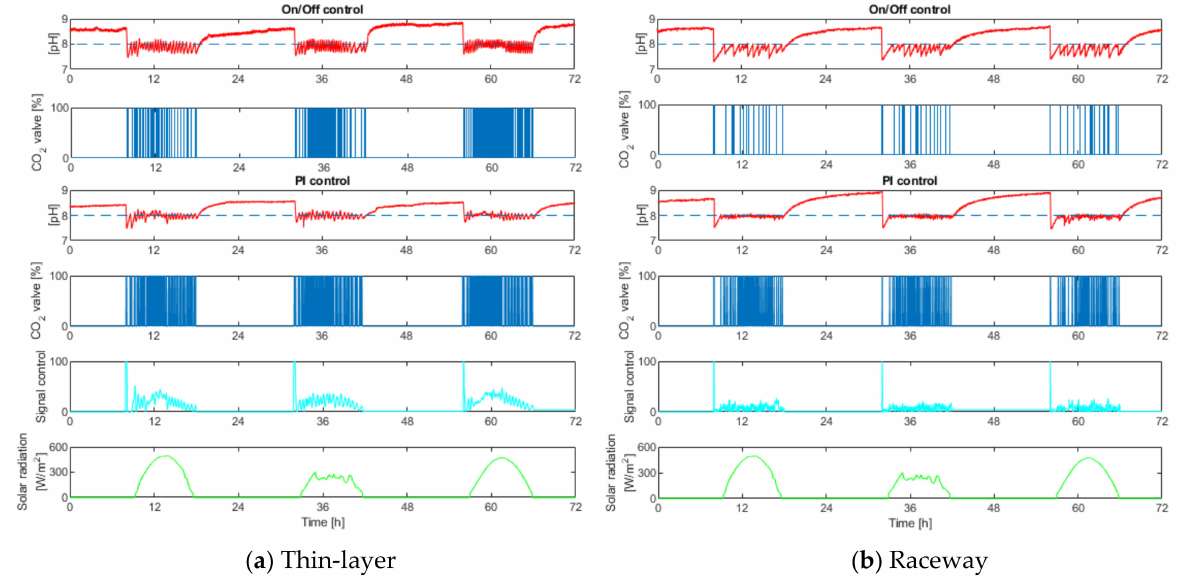
Figure 7. Results of the On/Off control and PI control architectures operated during the day, in thin-layer ( a ) and raceway ( b ) reactors. First graphs represent the evolution of the pH with On/Off controller (continuous red line), and the set-point established (dashed blue line). Seconds graphs represent the CO 2 valve state of On/Off control, Pulse Width Modulation (PWM) signal. Third graphs represent the evolution of the pH with PI controller (continuous red line), and the set-point established (dashed blue line). Fourth graphs represent the CO 2 valve state of PI control, PWM signal. Fifth graphs represent the control signal by PI control. Sixth graphs represent global radiation.